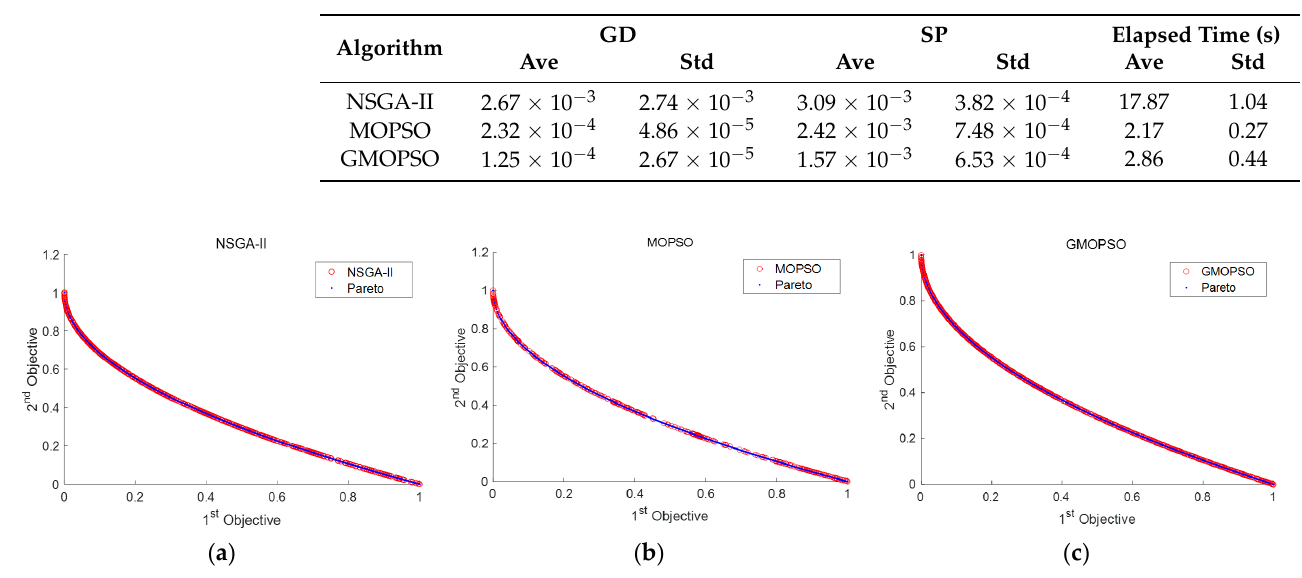
Figure 4. Test results of function ZDT1. ( a ) Pareto solutions of NSGA-II; ( b ) Pareto solutions of MOPSO; ( c ) Pareto solutions of GMOPSO.